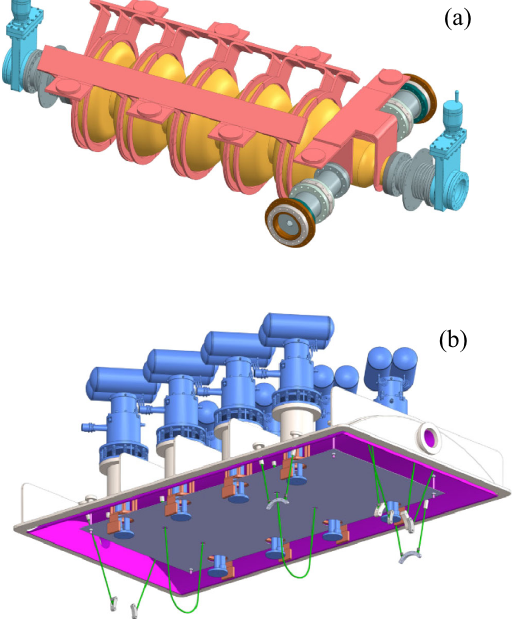
FIG. 25. CAD views of (a) the beam line assembly prior to installation in the cryocooler and (b) the beam line assembly suspended on the lid of the vacuum vessel.